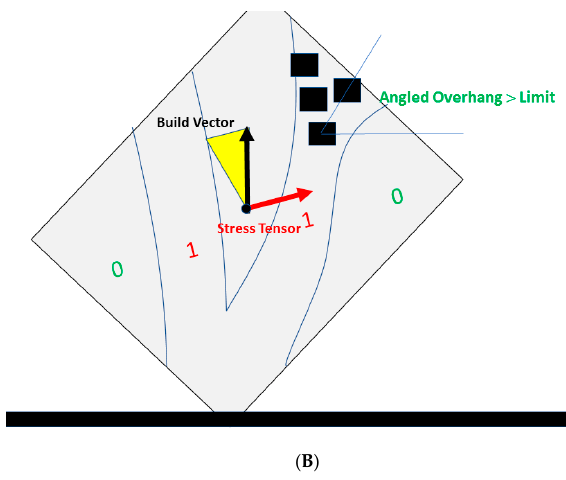
Figure 6. Allowed orientation rotation margin and its effect on AM manufacturability: ( A ) out-of- limit overhang feature and ( B ) within-limit overhang feature.